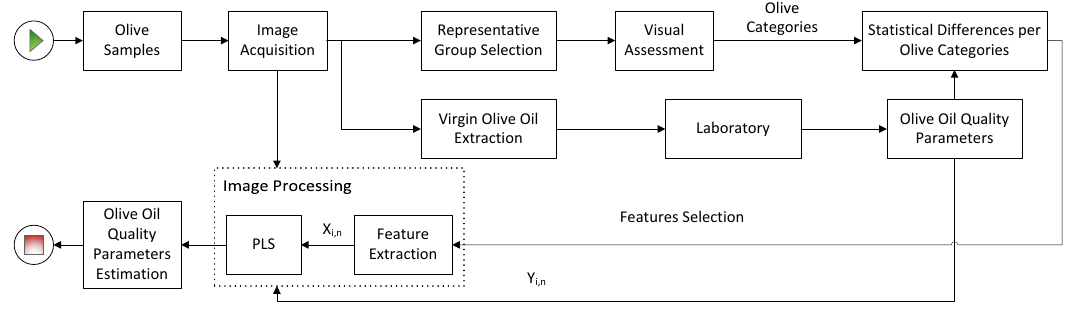
Figure 1. Overview of the proposed methodology for quality properties